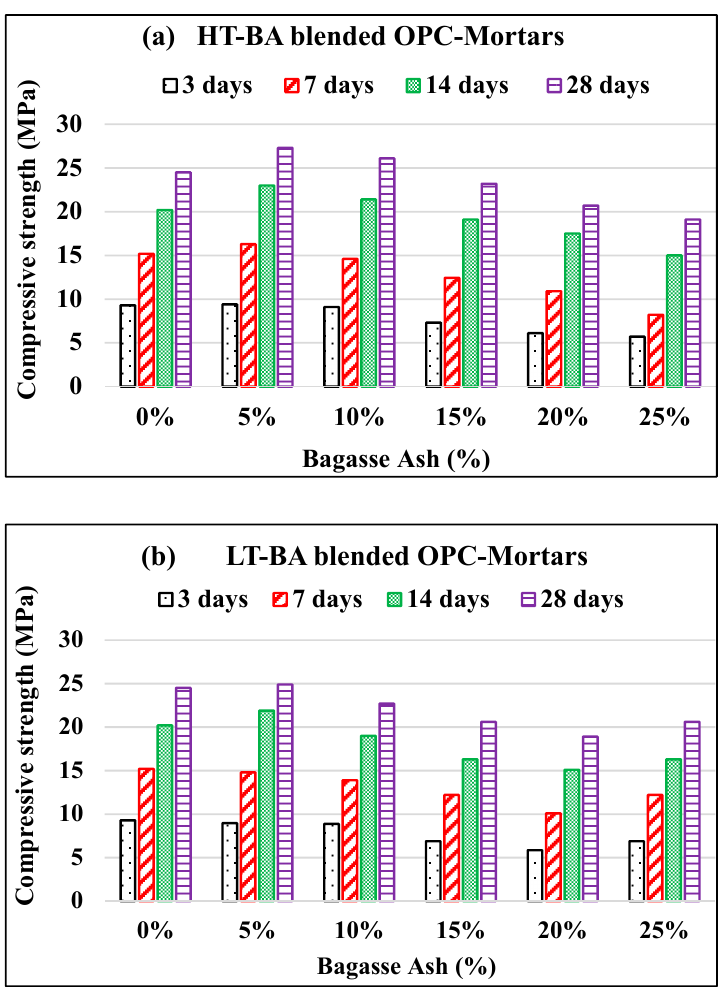
Figure 3. Compressive strength of bagasse ash-blended OPC mortars: ( a ) BA burned at 600 ◦ C/2 h